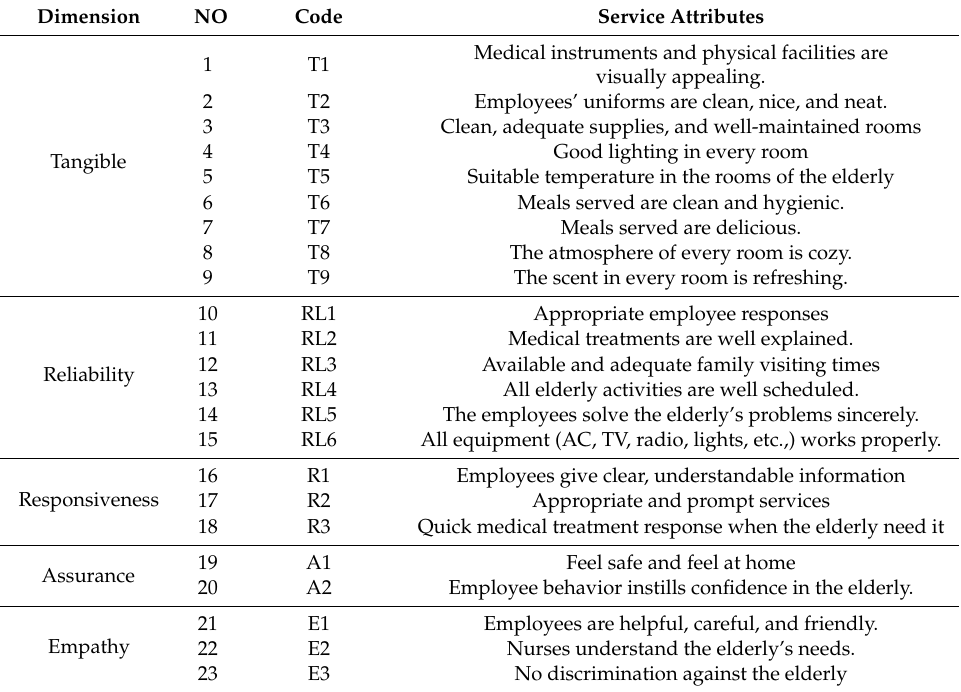
Table 2. The SERVQUAL attributes applied in this